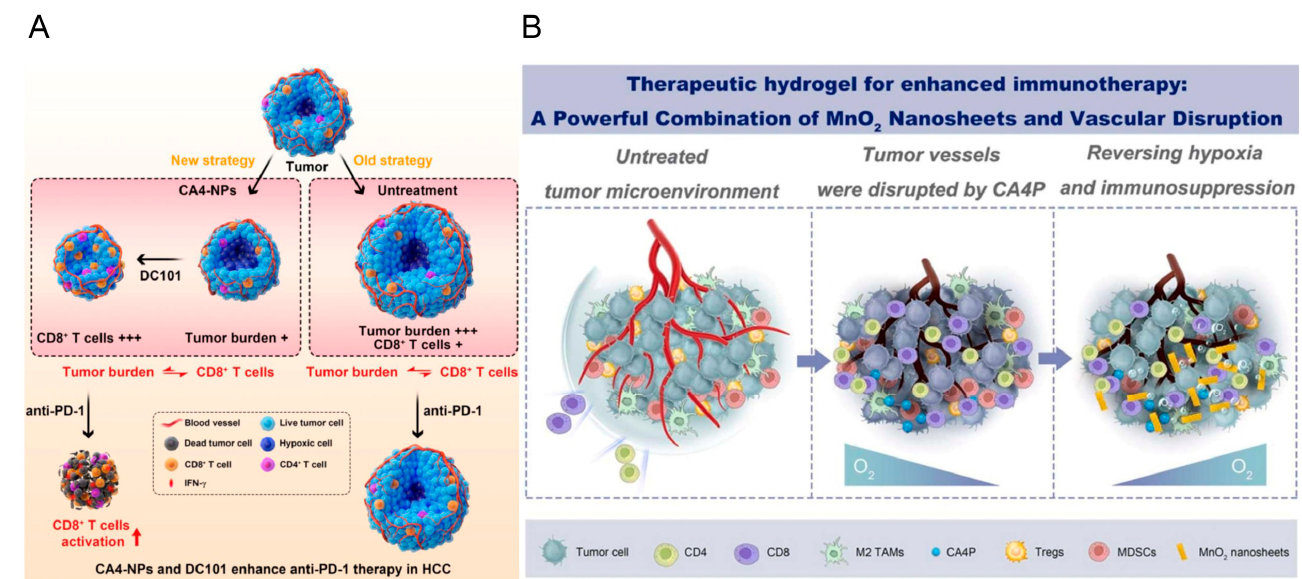
Figure 2. Antivascular therapy combined with nanoparticles can relieve immunosuppressive microenvironment. ( A ) MSNs synthesized, functionalized, and loaded with NH2, PBA, and DA, respectively. MSNs have a pH-responsive bond between PBA and DA that enables them to release in acidic pH upon arriving in the tumor microenvironment. Adapted with permission [41]. Copyright © The authors. ( B ) The therapeutic hydrogel (CM@Gel) combines with a vascular disrupting agent, CA4P, to alleviate tumor hypoxia after selective blockade of tumor nutrient sources [39]. Copyright ©